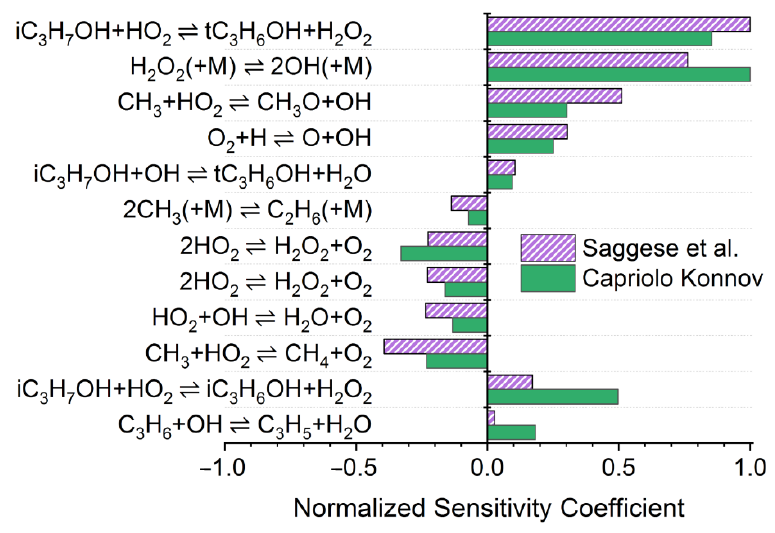
Figure 9. Sensitivity analysis for τ ign using the Capriolo and Konnov and Saggese et al. models conducted at 1100 K, 25 atm, and ϕ = 0.5.